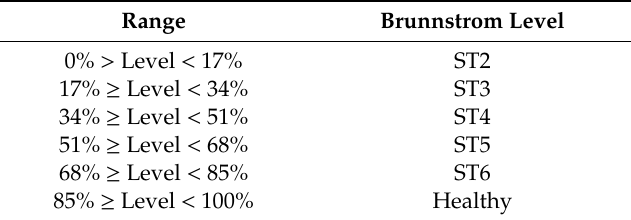
Table 7. Brunnstrom Level mapping table.